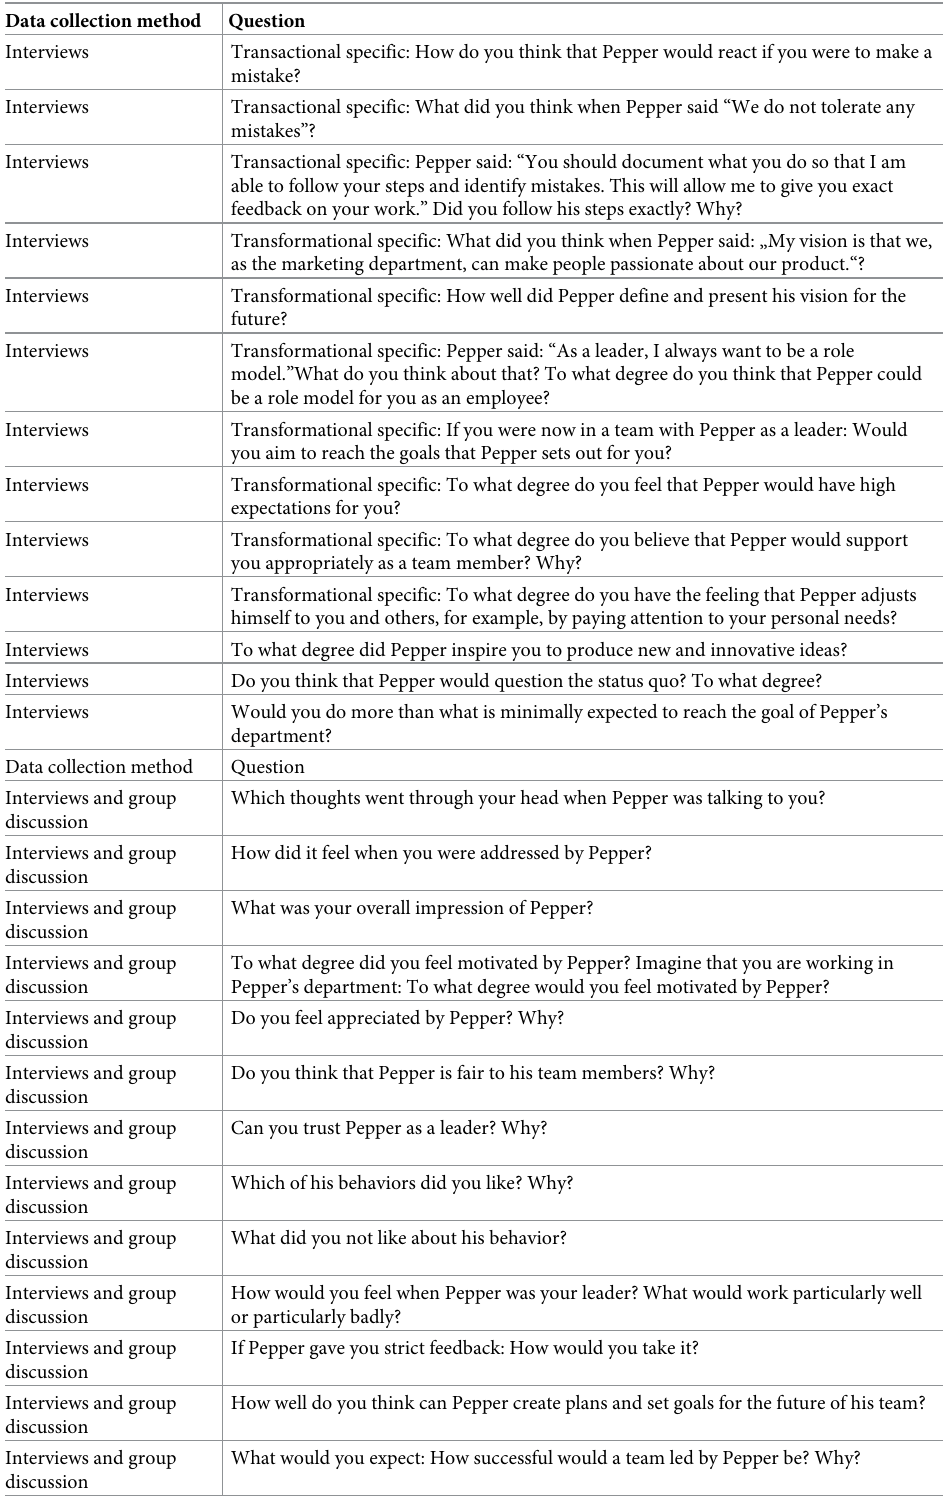
Table 1. Questions stated during interviews and group